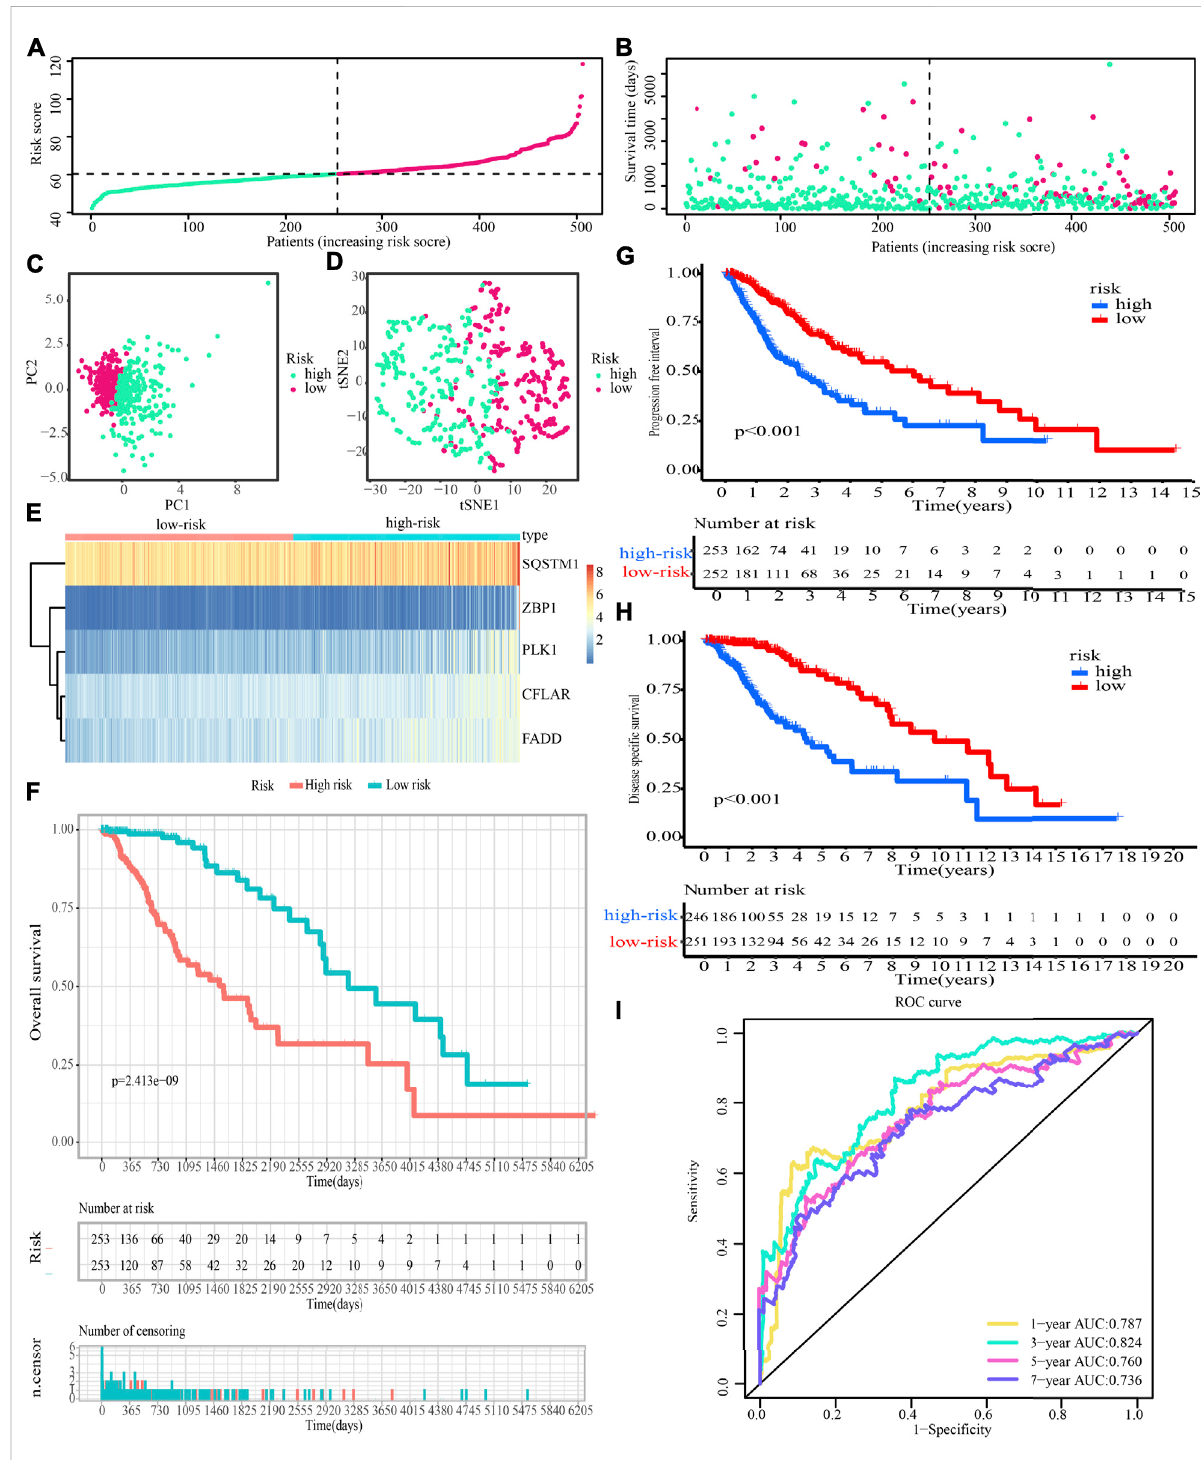
FIGURE 7 Evaluation of the prognostic signi fi cance of risk score in the training cohort. (A,B) Distribution of risk scores, patient survival time, and glioma status(Theline withblackdotsrepresentstheoptimumthresholdvaluefor categorisingpatients intolow- andhigh-riskpopulations). (C,D) PCAand t-SNE analysis illustratedan excellent clustering performance ofthe fi ve-gene-based risk score. (E) The expression patternsof fi veCNRGsthat were included in the signature as mapped out in a heatmap using the training dataset. (F – H) Survival curve of training cohort. (I) ROC curves of training